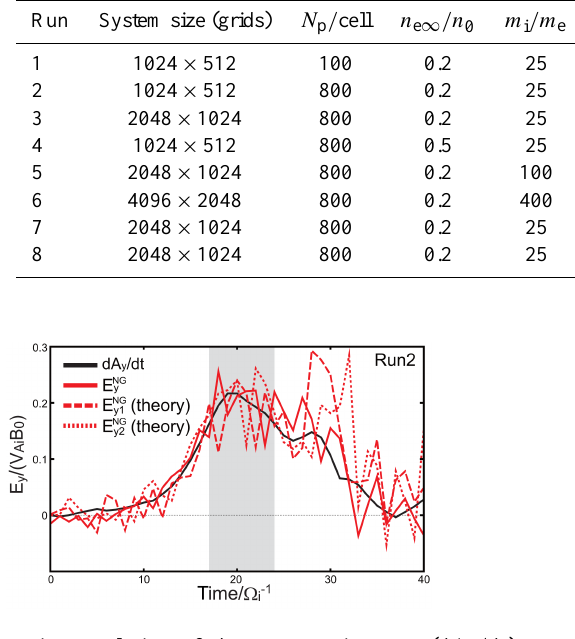
Figure 1. Time evolution of the reconnection rate (d A y / d t ), E NG y and the approximated E NG √ 2 m e T e zz U (cid:48) e z measured at the X-point. The shaded interval in- e dicates the quasi-steady phase which is defined as the time when | d A y / d t | > 0 . 75 | d A y / d t | max where | d A y / d t | max is the maximum value of the reconnection rate.